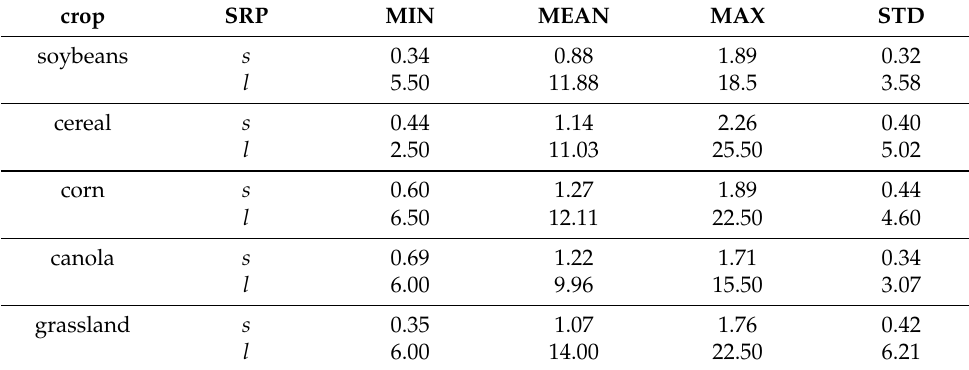
Table 5. Statistical parameters for the minimum (MIN), mean (MEAN), maximum (MAX) and standard deviation (STD) of the surface roughness parameters (SRP): surface root mean square height ( s ) and correlation length ( l ) (unit: